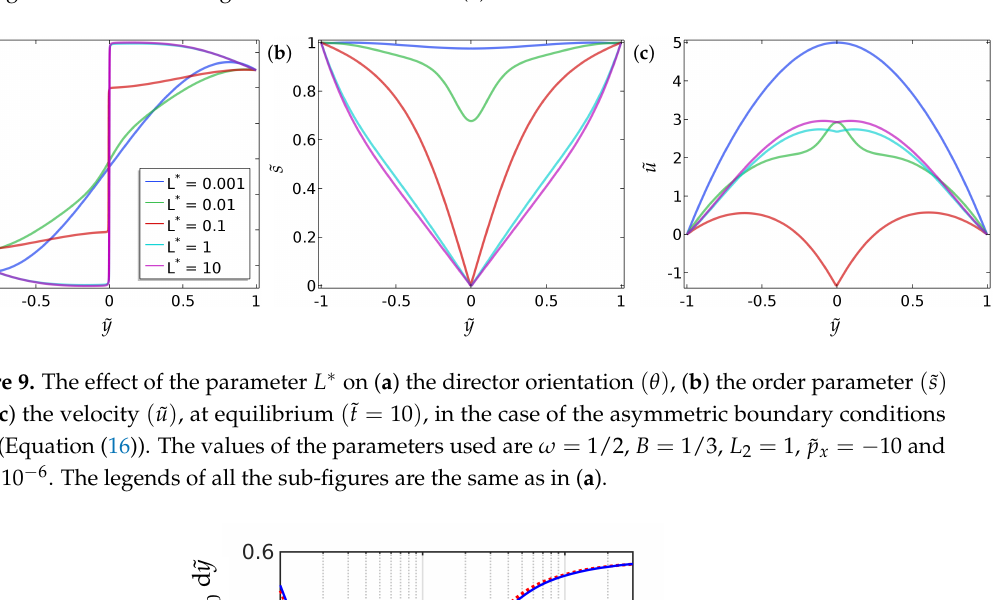
10 and L 1 = 10 − 6 . −